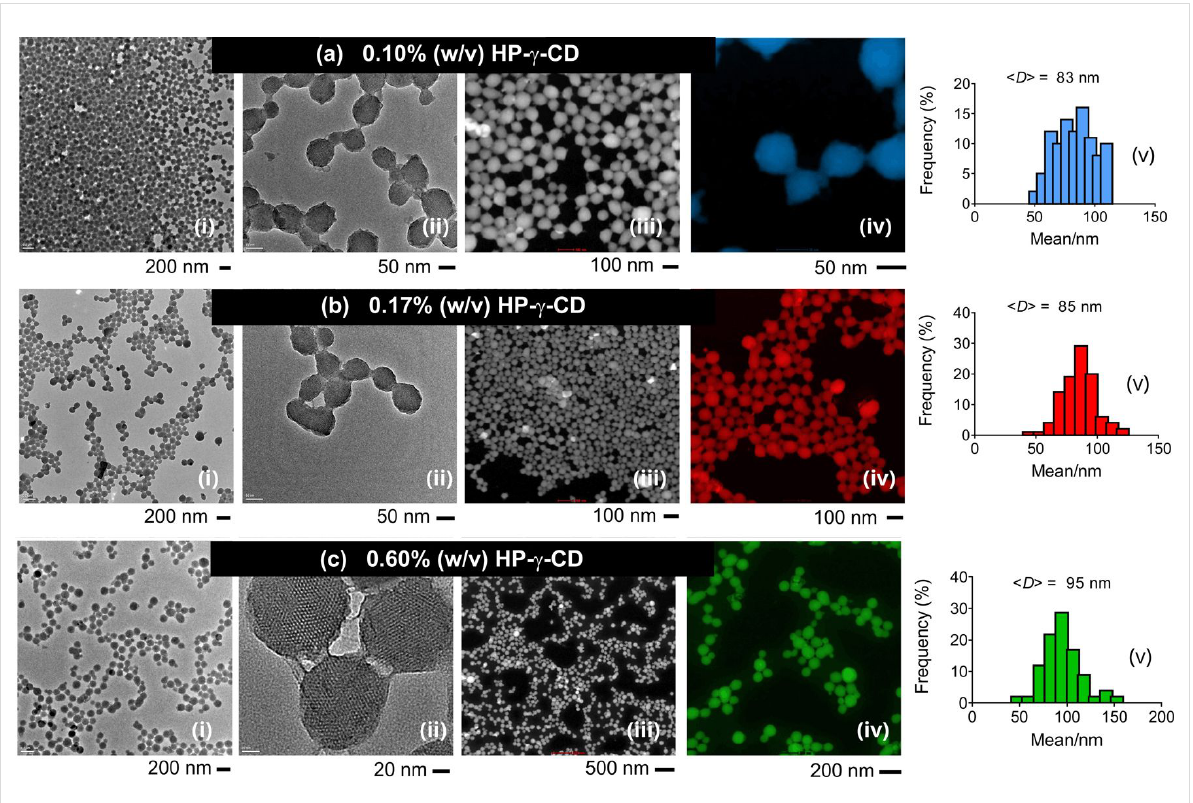
Figure 6: TEM (i, ii), colored STEM (iii, iv) images, and the particle size-distribution plots (v) of MSNs (MSN-10-12) produced at various HP- γ -CD con- centrations. c CTAC = 0.40% (w/v), c HP- γ -CD = 0.1 (a), 0.17 (b) and 0.6% (w/v) (c), and r (CD/CTAC) = 0.25 (a), 0.42 (b) and 1.5 (c). The average particle size was calculated from the diameters of the single particles.